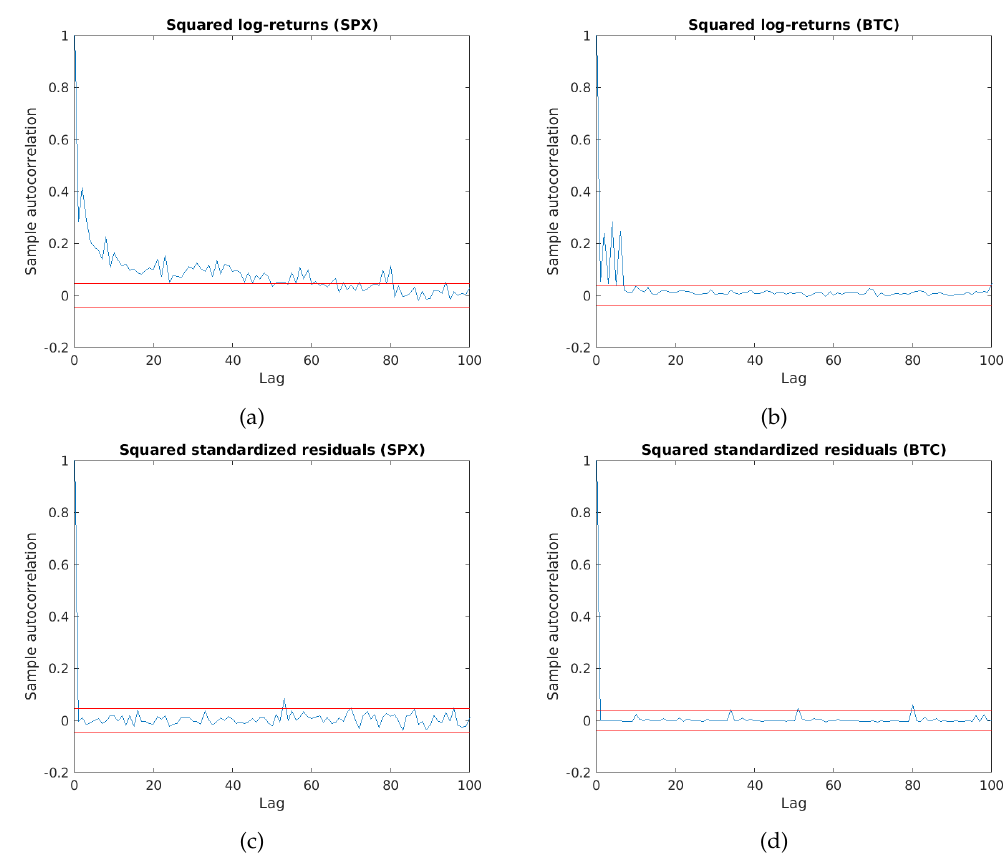
Figure 5. Autocorrelation function for the squared returns for ( a ) SPX and ( b ) BTC data and squared standard residuals for ( c ) SPX and ( d ) BTC